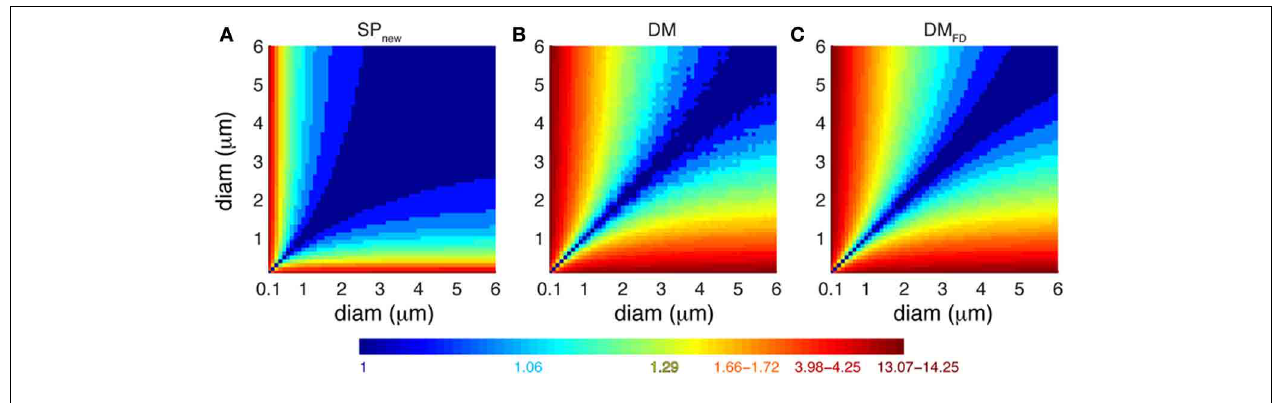
FIGURE 7 | Different Ca 2 + buffering model respond variably to changes in dendrite diameters. Predicted ratio of integrated Ca 2 + concentration (100ms window) for different combinations of diameters of pairs of dendritic compartments using (A) SP new ,